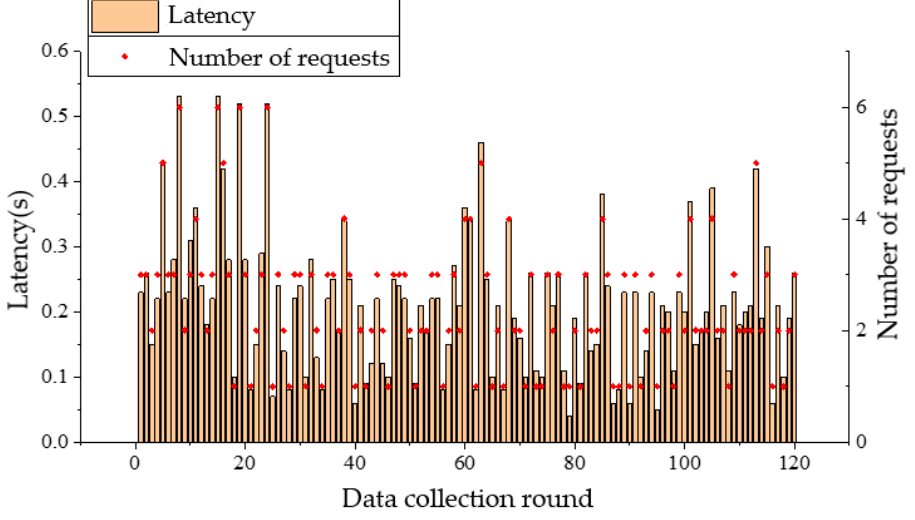
Figure 17. Communication latency of node B and the number of requests from UAV when flight altitude is 5 m.